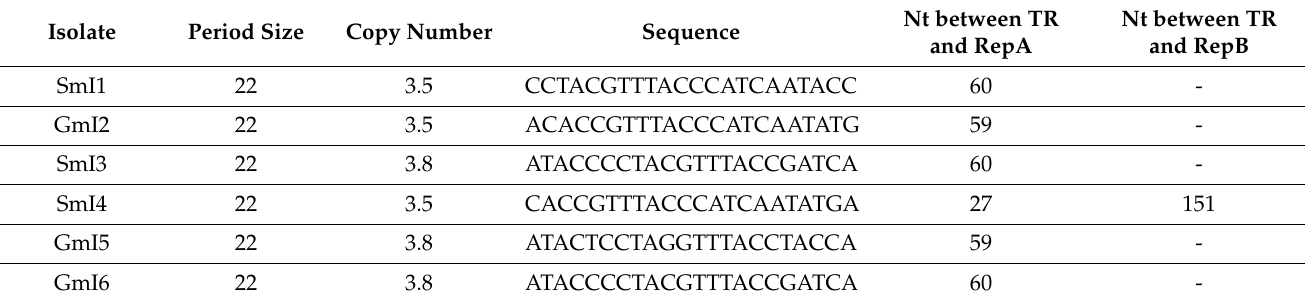
Table 3. Tandem repeats that are typically located upstream the rep -gene possibly function as replicase recognition sites. The RCR mechanism of these DNA elements is further supported by inverted repeats, which are located 49–56 nt upstream the tandem repeat region. All BMMF1-related isolates exhibit such a palindromic sequence similar to a motif in BMMF1 elements published by zur Hausen et al. [17]. Table 3. BMMF-like DNA isolates and inherent tandem repeat